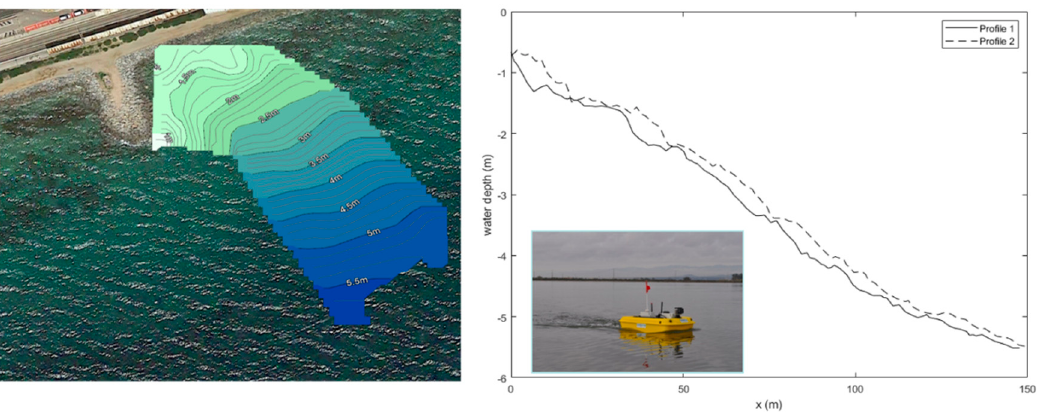
Figure 4. Bathymetry extracted from the LIM/UPC drone survey ( left plot ) and resulting profiles by merging existing data with the carried-out survey ( right plot ). A photo of the drone is in the small picture.